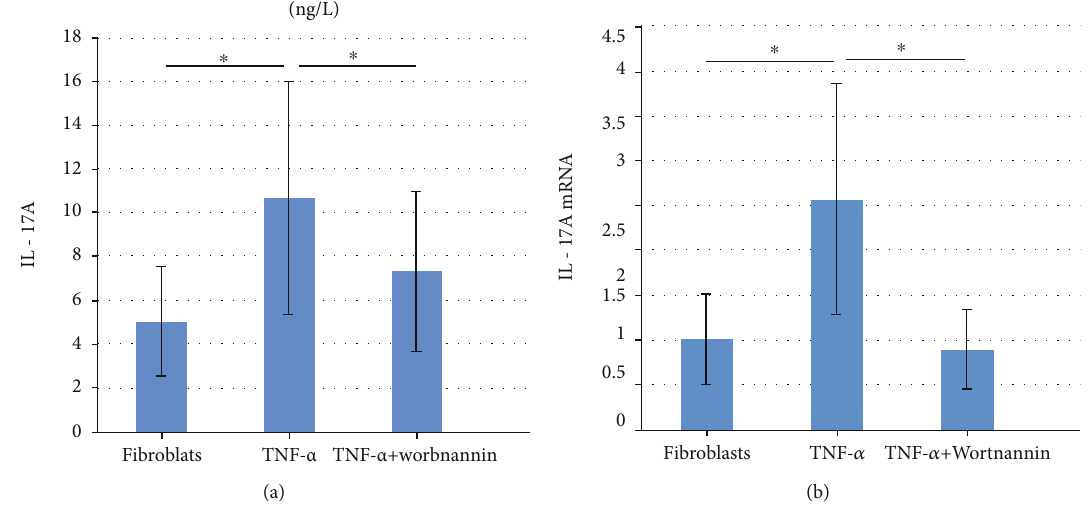
Figure 5: The expressions of IL-17A in fi broblasts from nasal polyps. (a) By ELISAs, after TNF- α stimulation, the IL-17A level in nasal polyp fi broblasts was signi fi cantly increased. P = 0 : 006 . After treatment with Wortmannin, the IL-17A level in nasal polyp fi broblasts was signi fi cantly reduced. P = 0 : 014 . (b) By RT-PCR, after TNF- α stimulation, expression of IL-17A mRNA in fi broblasts of nasal polyps was signi fi cantly increased. P = 0 : 049 . After treatment with Wortmannin, the IL-17A mRNA level in nasal polyp fi broblasts was signi fi cantly reduced. P = 0 : 015 . ∗ P < 0 : 05